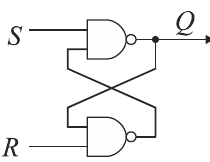
Figure 13. Time comparator F k based on RS latch.